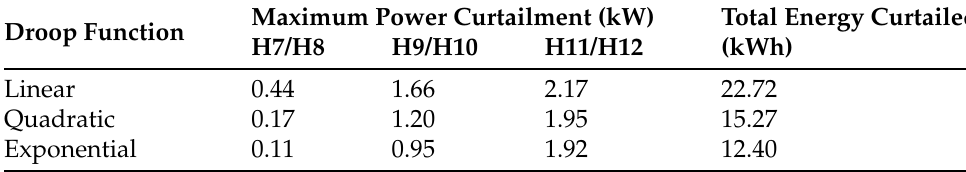
Figure 10. Voltage profile of twelve houses (House 1 to House 12) and curtailed power in APC method with exponential droop. Table 1. Maximum power curtailment and energy curtailed for different droop